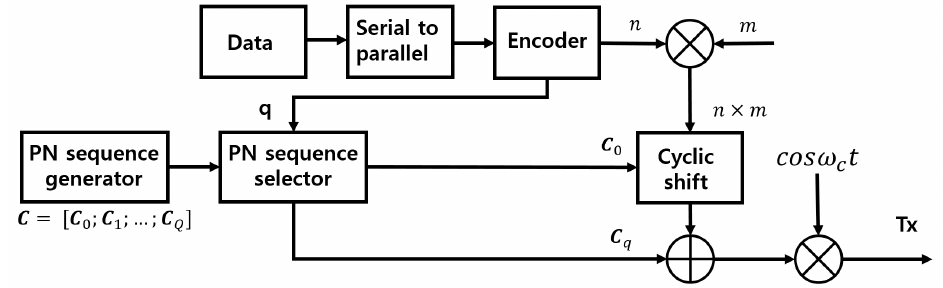
Figure 2. Block diagram of transmitter.